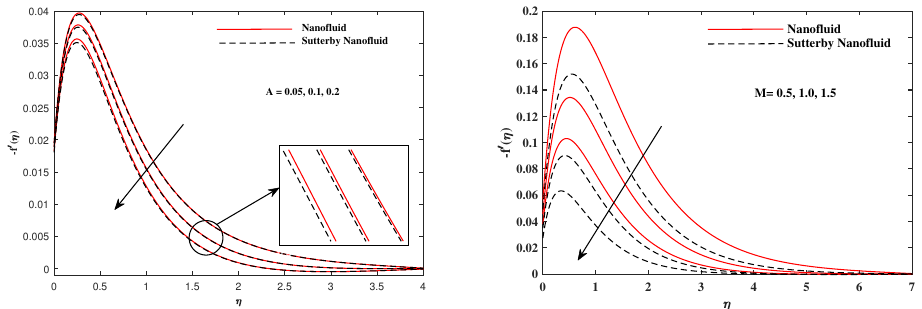
Figure 2. f (cid:48) ( η ) fluctuate in x-direction with A and M .